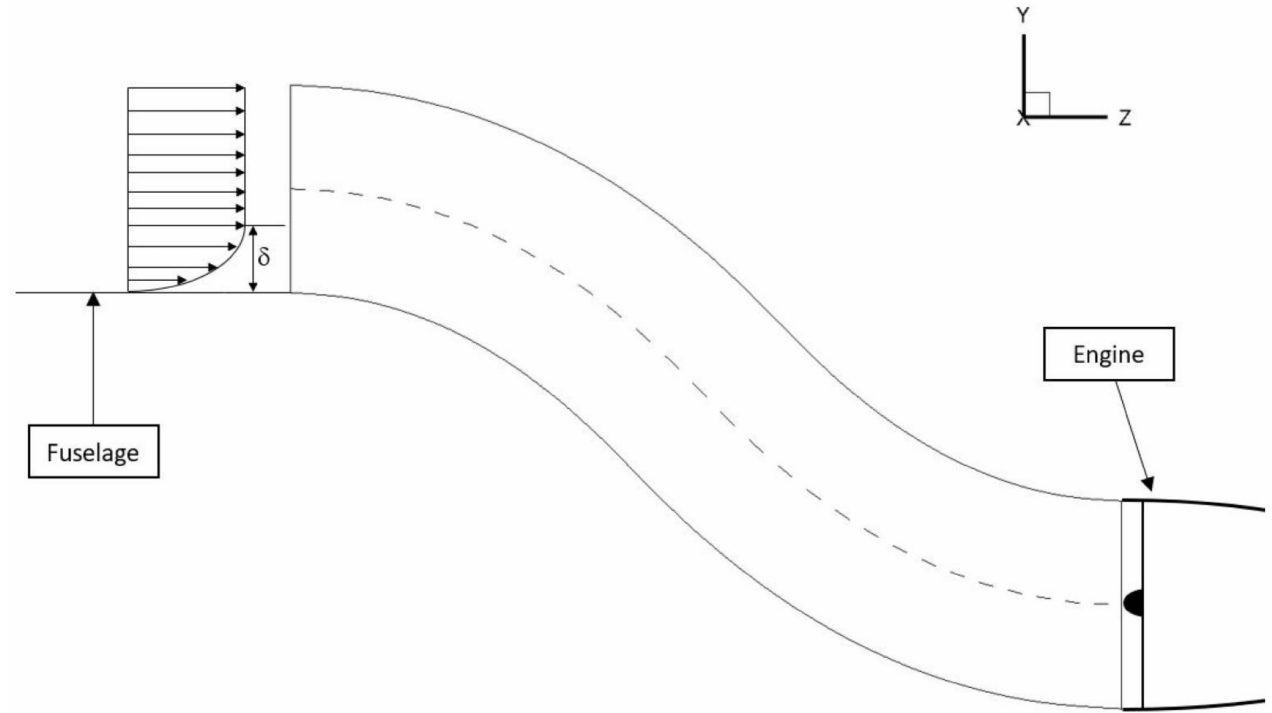
Figure 1. Schematic of boundary layer